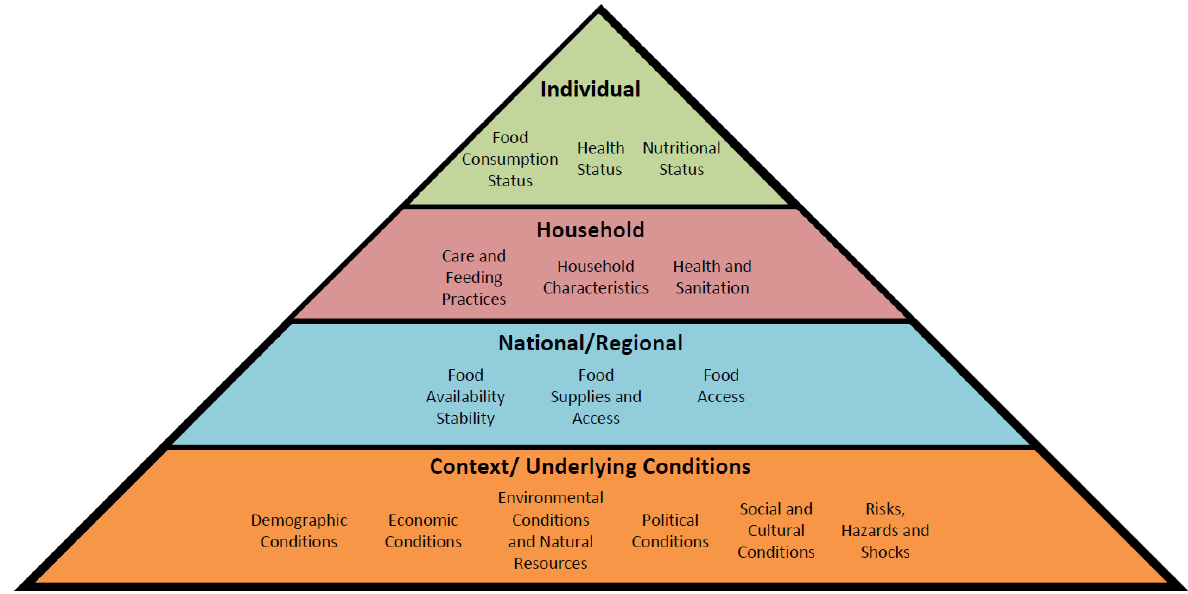
Figure 1. Different levels of food security. Based on ideas from the Committee on Food Security [13] and the FIVIMS initiative